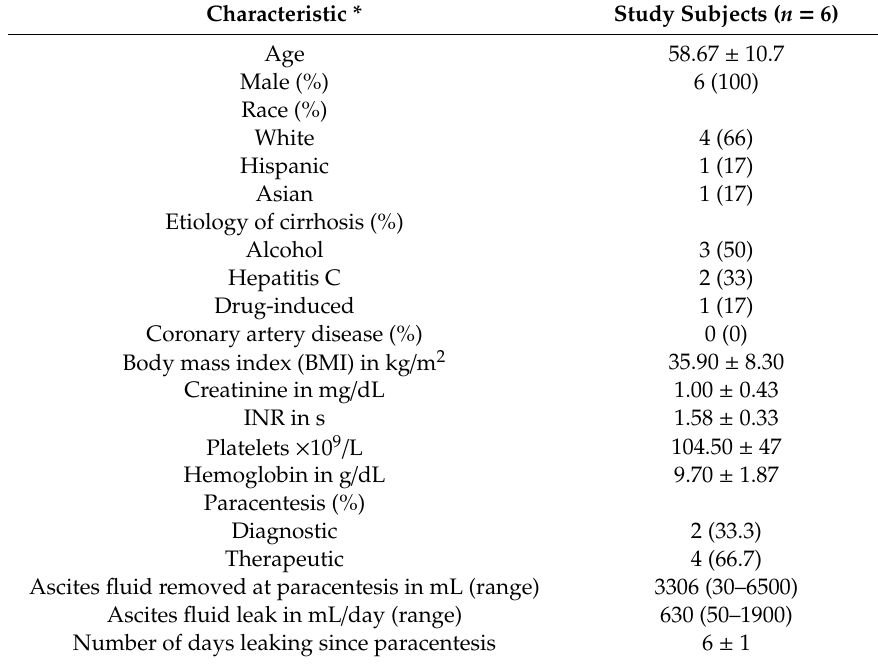
Table 1. Baseline characteristics of subjects.